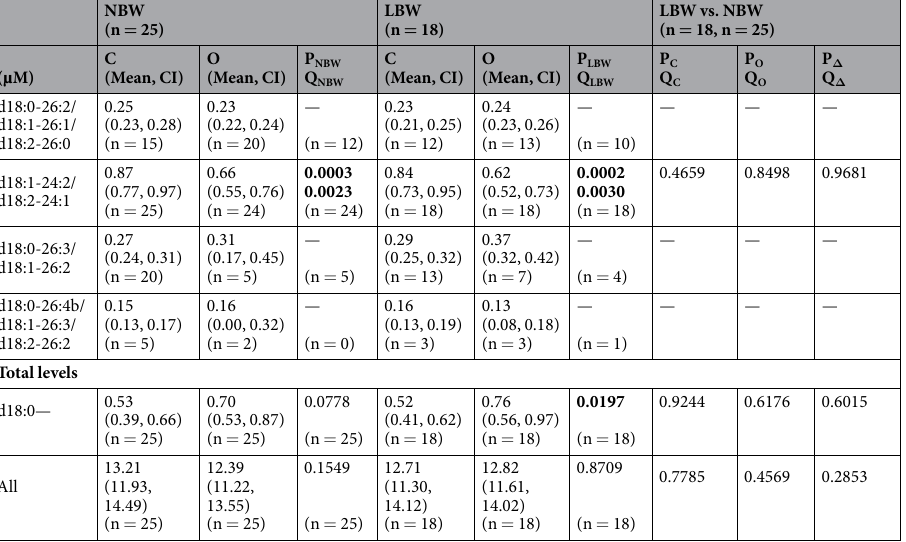
Table 2. Plasma ceramide levels in low (LBW) and normal birth weight (NBW) men following the control (C) and high-fat, high-calorie (O) diets. Data are presented as mean values with 95% confidence intervals (CI). P-values ≤ 0.05 are presented together with Q-values, and P-values ≤ 0.05 with corresponding Q-values ≤ 0.05 are considered statistically significant. P-values were not calculated, if more than 25% of the values within one of the two groups to be compared were missing. P NBW and P LBW : O vs. C diet within each birth weight group, P C and P O : LBW vs. NBW men within each diet, P Δ : LBW vs. NBW men on response values. P-values ≤ 0.05 and Q-values ≤ 0.05 are marked in bold. Total d18:0 − levels: d18:0–16:0, d18:0–23:0, d18:0–22:1,